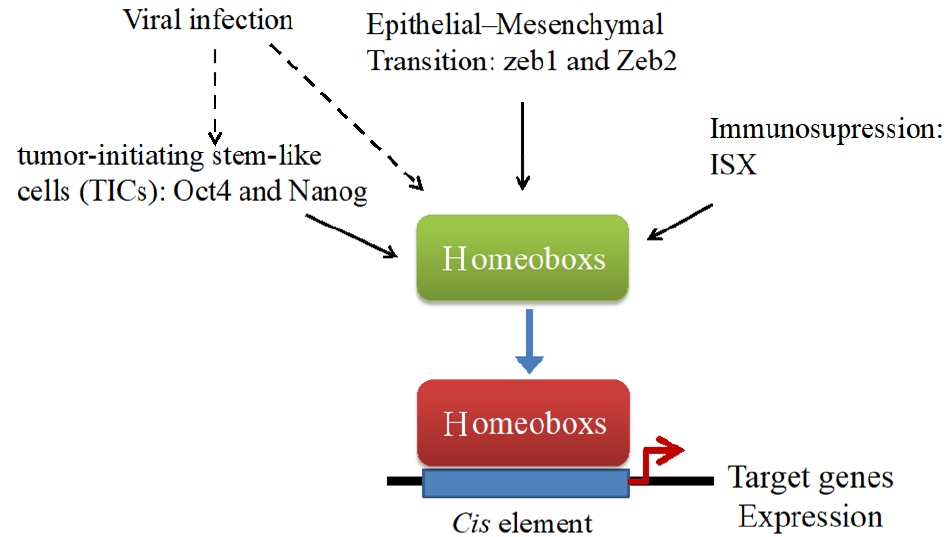
Figure 1. Homeobox genes participate in the generation of hepatocellular carcinoma (HCC). The Homeobox genes positively and negatively regulate in tumorigenesis of HCC, including tumor-initiating stem-like cells, epithelial to mesenchymal transition, immunotolerance, and viral infection (hepatitis B virus (HBV) and hepatitis C virus (HCV)). The altered transcriptional regulation of Homeobox genes that we assigned in the figure dramatically rearranges the downstream genes’ expression, which participates in promotion of HCC tumorigenesis.